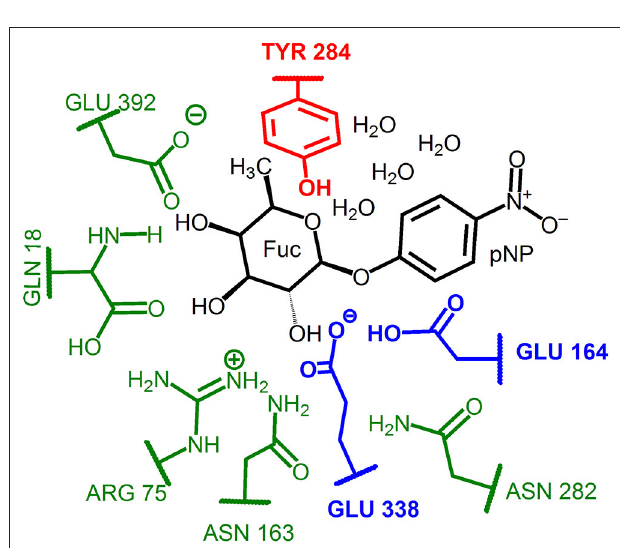
FIGURE 3 | Representation of the QM regions used in the QM/MM study of the glycosylation reaction. The small QM region includes: the substrate atoms and water molecules (in black), the catalytic residues (in blue) and the Tyr184 residue (in red). For the hydrolysis and transglycosylation the O- p NP group was substituted by a water molecule and the BnON(Me)-Glc acceptor substrate, respectively. Three additional waters were included for the hydrolysis and just one for the transglycosylation step. The large QM region comprises for the three reaction steps the corresponding small QM region plus the protein residues depicted in